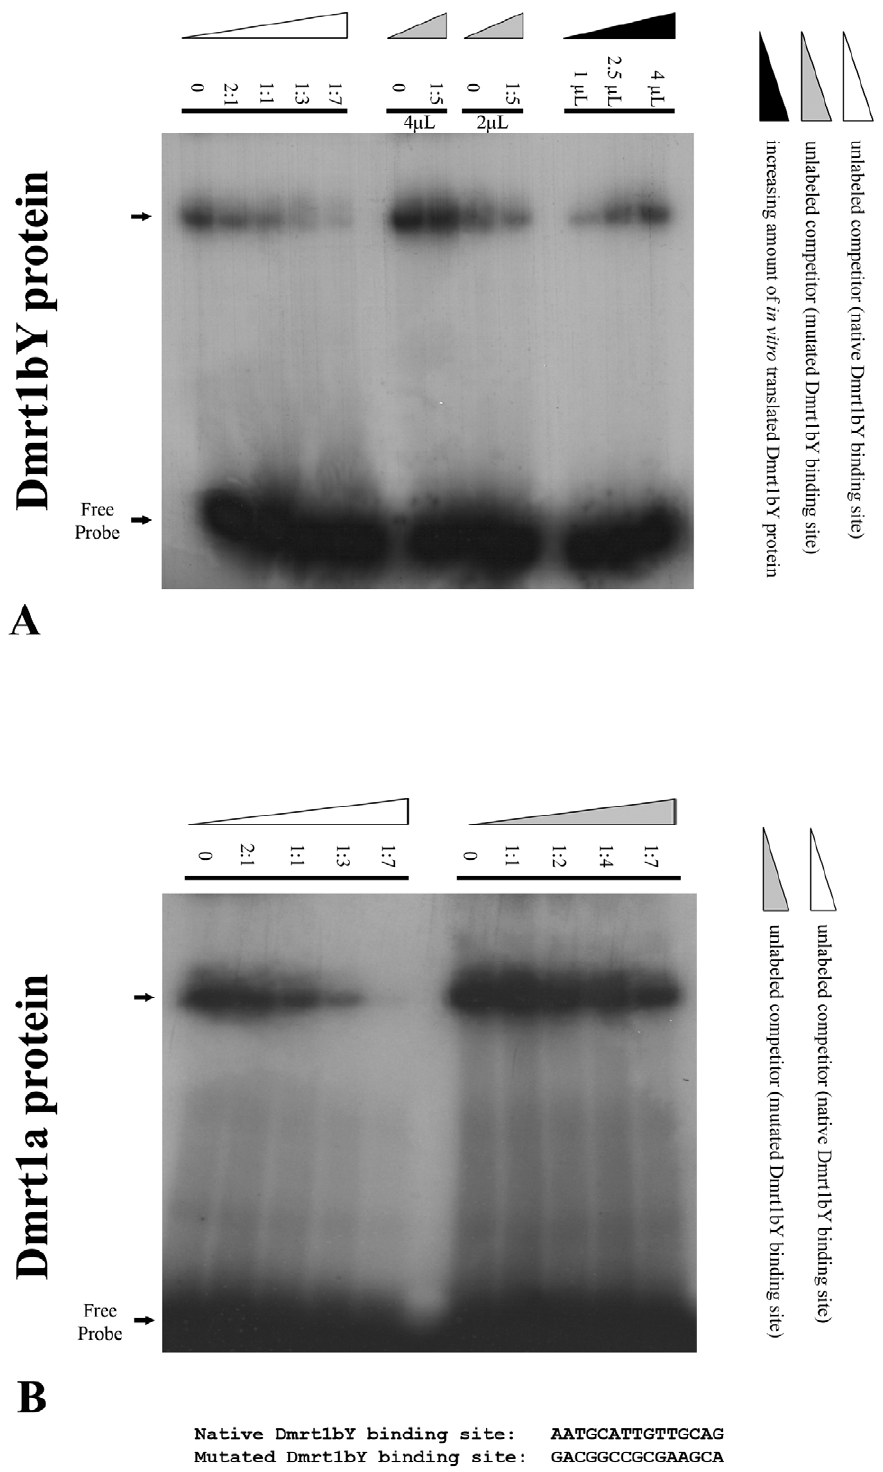
Figure 4. Electrophoretic Mobility Shift Analysis (EMSA) of invitro translated Dmrt1bY protein interaction with the Dmrt1 binding target derived from its own promoter. Gel mobility shift using increasing amounts of either in vitro translated Dmrt1bY or Dmrt1a proteins to shift a constant amount of radiolabelled dmrt1 probe. Binding reactions were resolved on a 5% polyacrylamide gel. (A) In vitro translated Dmrt1bY protein was incubated with radiolabelled Dmrt1bY target sequence as a probe, and non-radiolabelled probe was used as a competitor. (B) In vitro translated Dmrt1a protein was incubated with radiolabelled Dmrt1bY target sequence as a probe, and non-radiolabelled control (non-specific) probe was used as a competitor.